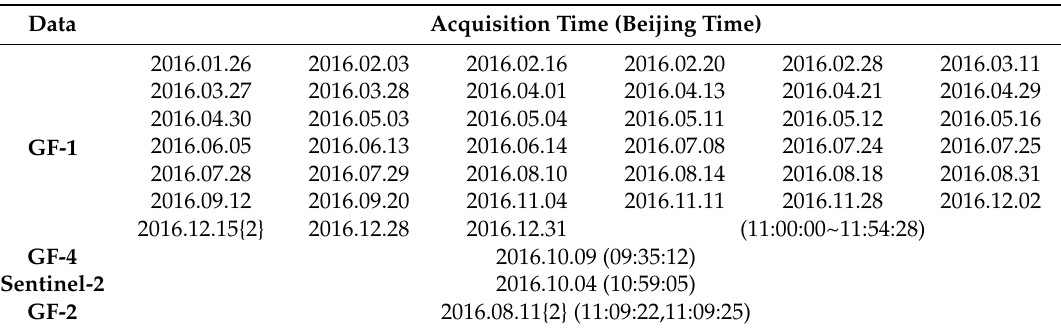
Table 1. Experimental satellite data acquisition time. Data Acquisition Time (Beijing